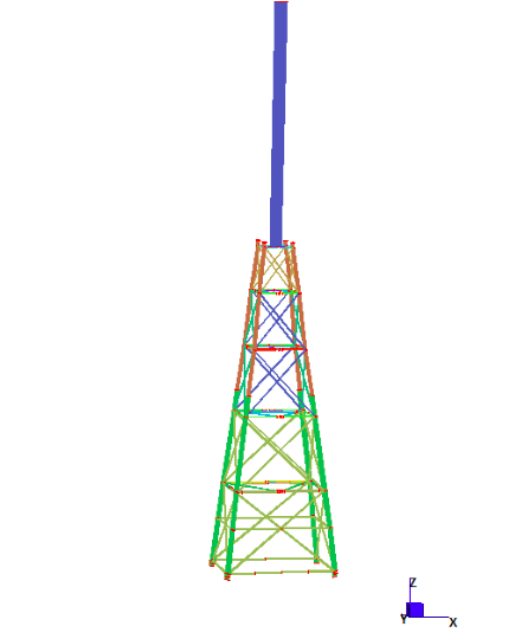
Figure 22. The 2-MW model